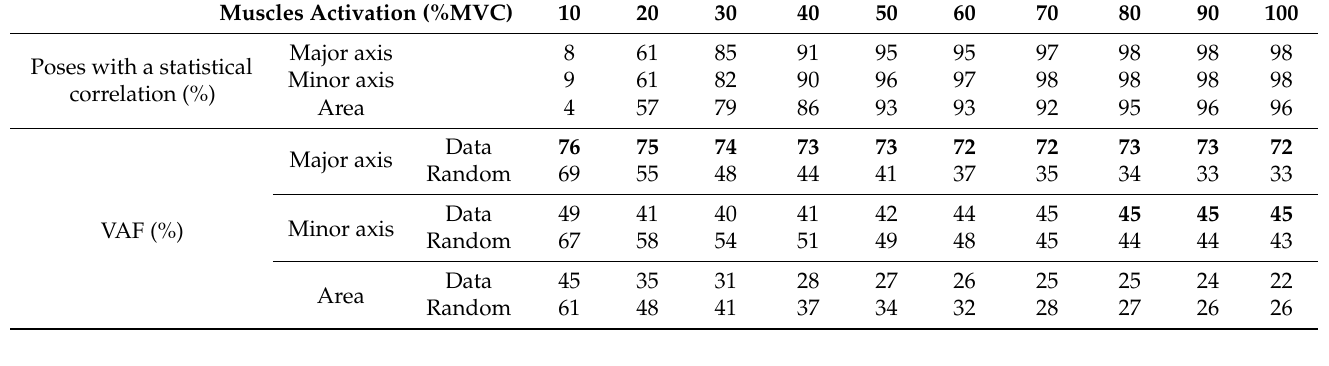
Table 1. Quality of the fitting of the major axis, the minor axis, or the area of the stiffness ellipse, as simulated with the musculoskeletal model, as the product of the null-space projection of the muscle activation normalized to the ratio between the mean null-space projection of the muscle activation divided by the mean value of the ellipse axes or area. The top rows show the percentage of the musculoskeletal model poses, showing a significant ( p < 0.05) regression between the stiffness ellipse axes or area and the norm of the null-space projection. The bottom rows show the VAF of the approximation of the stiffness ellipse axes or area as the product of the null-space projection of the muscle activation (“Data”) and as the 95% percentile, over 500 repetitions, of the product of the null-space projection of the muscle activation, randomly shuffled during each repetition (“Random”). Values reported on the “Data” rows in bold were higher than the “Random” ones reported immediately below. The regression and the fitting were performed for data whose activation of each muscle was lower than the selected value.